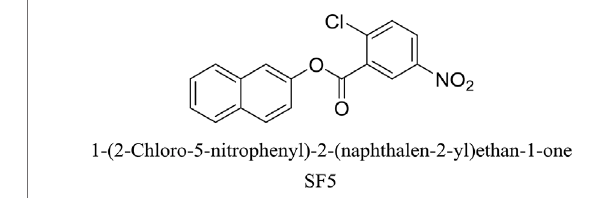
FIGURE 1 | Chemical structure of SF5.